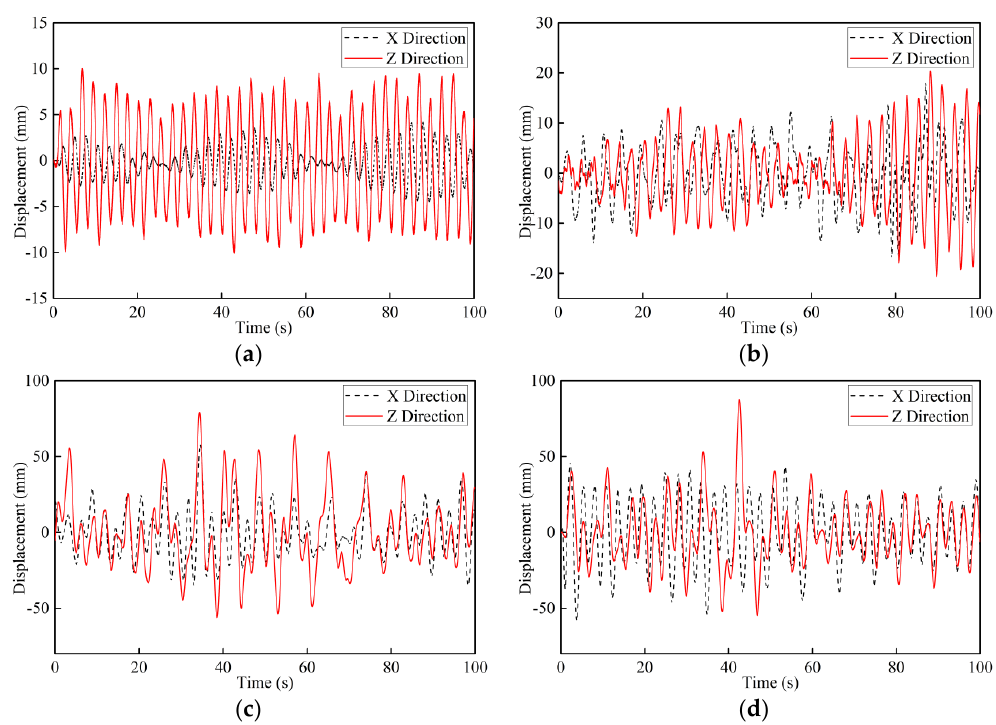
of 3.1 m/s. of 3.1 m/s.